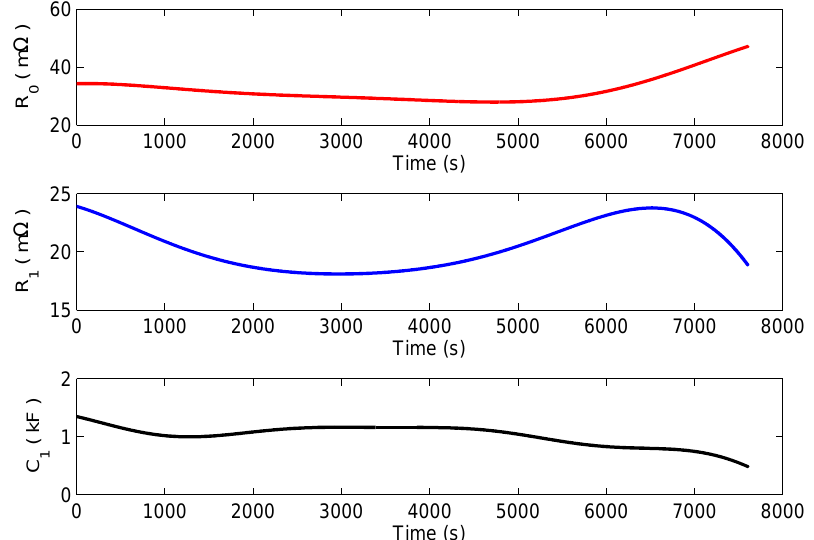
Figure 4. Results of parameter identification using variational Bayesian approximation-based adaptive dual extended Kalman filter (VB-ADEKF) in the constant current discharge